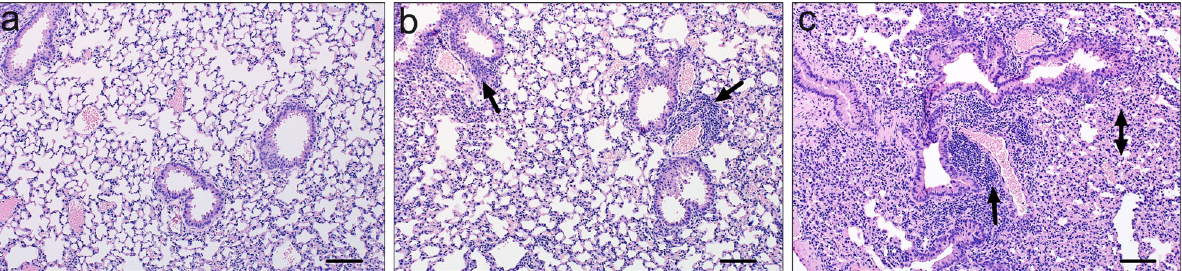
Fig. 8 Analysis of histology indicates the CLH001 and PBK001 vaccination is associated with mild to moderate lung in fl ammation post vaccination. The lungs ( n = 3/group) of mice receiving PBS ( a ), CLH001 ( b ), or PBK001 ( c ) were collected 2 weeks after the 2 nd boost. The lungs were placed in 10% formalin, fi xed, paraf fi n-embedded, and stained with hematoxylin and eosin (H&E). The stained tissue sections were examined in a blind manner by a pathologist. The lungs of animals vaccinated with PBS was mostly non-remarkable except for some areas of mild interstitial in fl ammation. In lungs of CLH001 vaccinees, some areas of bronchovascular in fi ltrates (single arrow) were observed. The bronchovascular in fi ltrates were a more prevalent characteristic in lungs of mice vaccinated with PBK001, and frequent interstitial in fl ammation (double arrow) was also observed. Representative fi elds of view for lung tissues were taken at ×10 magni fi cation. The scale bar represents 100